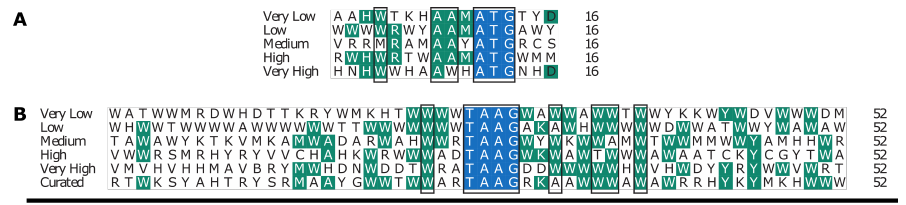
Figure 8. Consensus sequences calculated from multiple sequence alignments. ( A ) Consensus sequence for the nucleotide sequences flanking the translation initiation site and ( B ) the late gene pro- moter motif. Consensus sequences were calculated from multiple sequence alignments of sequences extracted from Ac MNPV ORFs that were categorized according to transcript